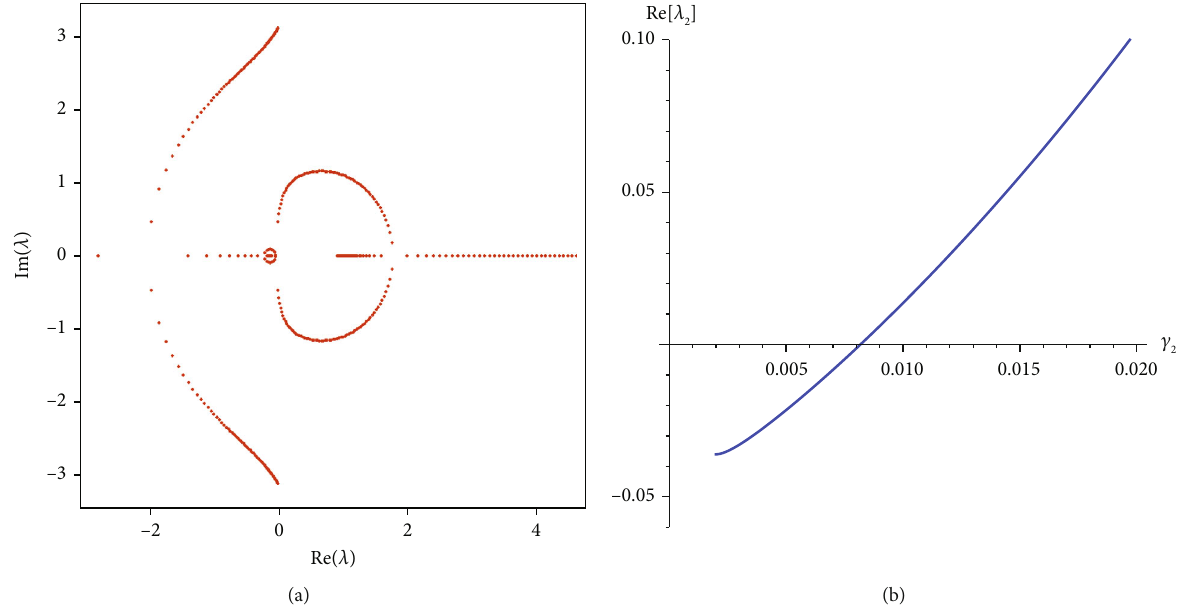
≤ 0 : 18 . (b) Plot of real part of the eigenvalue λ 2